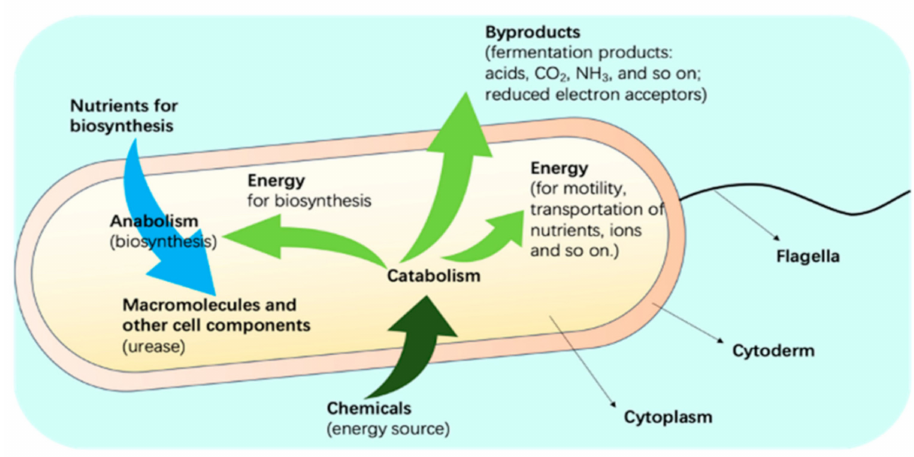
Figure 10. The metabolic process of urease-producing bacteria using dairy wastewater